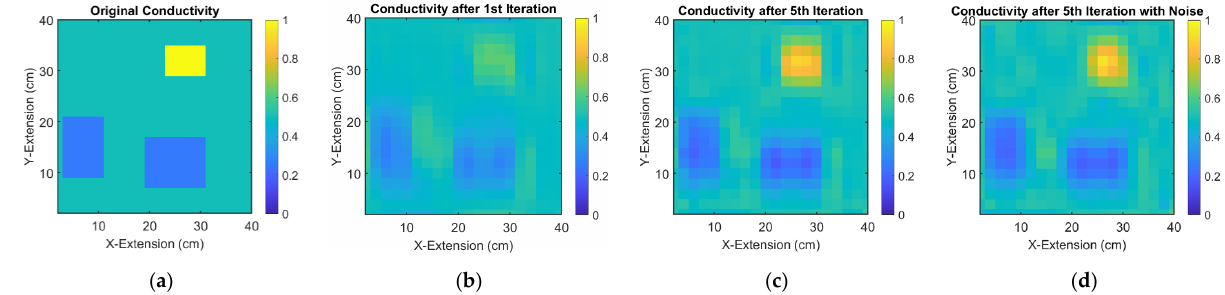
Figure 9. Conductivity reconstruction of a 2D, weakly conductive, and inhomogeneous object from measured currents: ( a ) original measurement object; ( b ) 2D reconstruction of the object after 1 iteration; ( c ) 2D reconstruction of the object after 5 iterations; ( d ) 2D reconstruction of the object after 5 iterations with artificial noise in the signal (40 dB SNR).